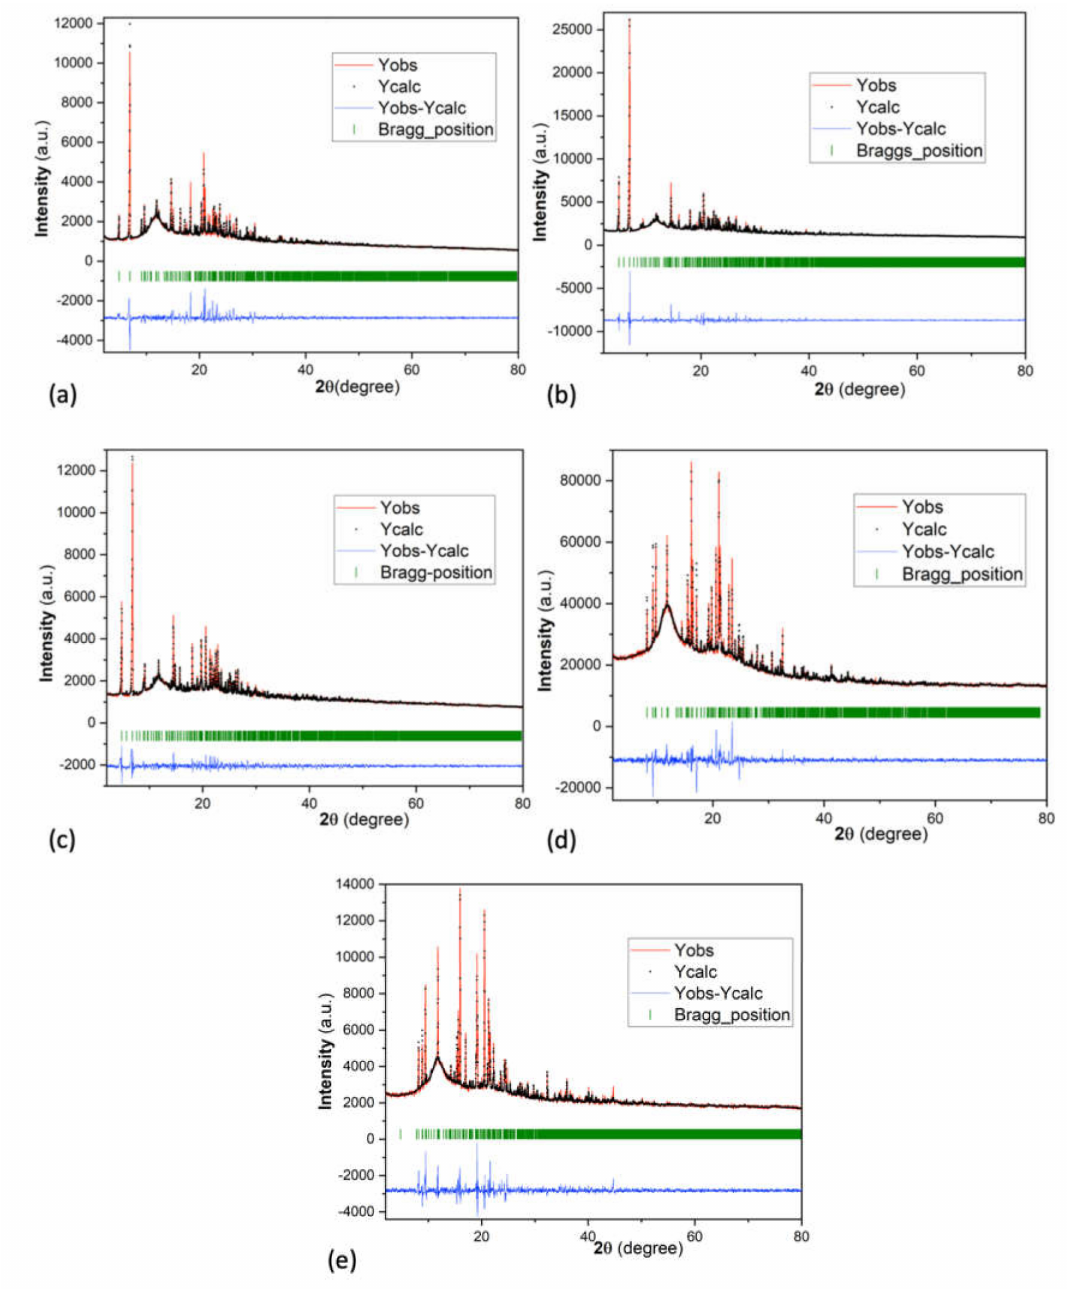
Figure 3. Laboratory powder X-Ray di ff raction (CuK α 1 radiation, 298 K) pattern (red trace) of each bulk crystalline material from which single crystals of ( a ) [{Co( 2 ) 2 (NCS) 2 } . 0.6CHCl 3 ] n , ( b ) [{Co( 3 ) 2 (NCS) 2 } . 4CHCl 3 . 0.25H 2 O] n , ( c ) [{Co( 4 ) 2 (NCS) 2 } . 4CHCl 3 ] n , ( d ) [Co 2 ( 5 ) 4 (NCS) 4 ] n and ( e ) [Co( 6 ) 2 (NCS) 2 ] n were selected. Each experimental powder pattern was fitted to the predicted pattern from the single crystal determination. The black dots correspond to the best fit from the profile matching refinement. Lower vertical green marks denote the Bragg peak positions. The bottom (blue) line in each plot represents the di ff erence between the experimental and calculated